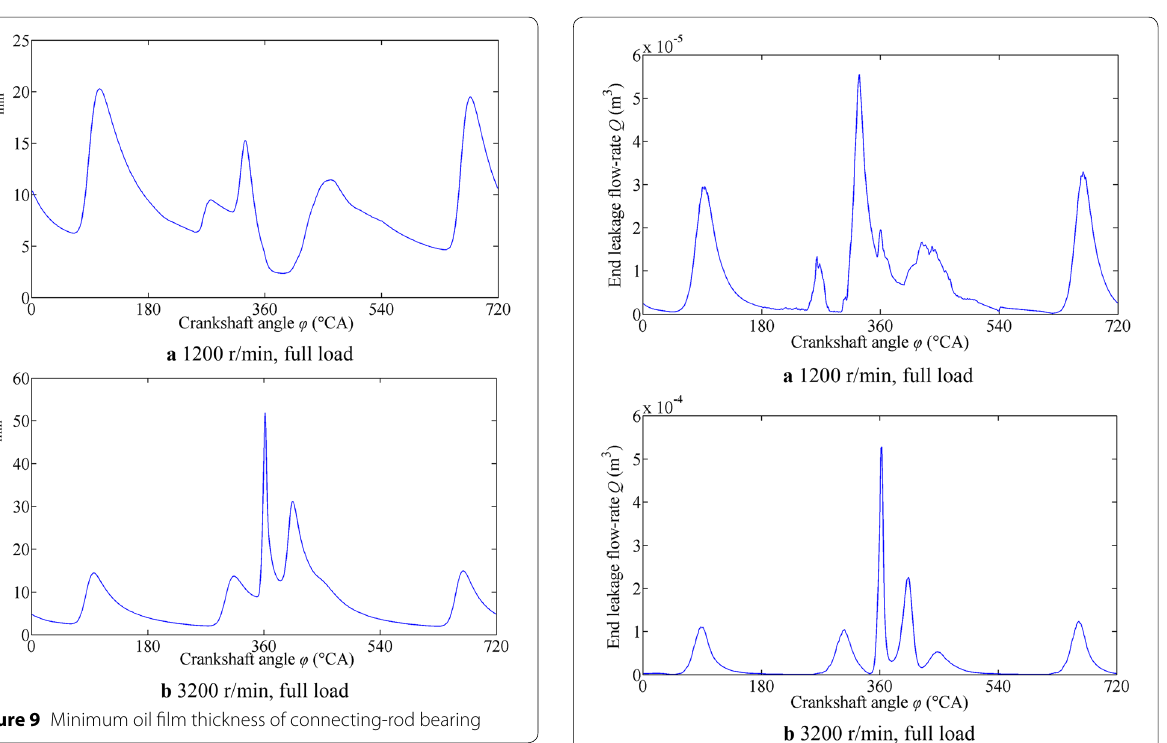
Figure 11 End leakage flow-rate of connecting-rod